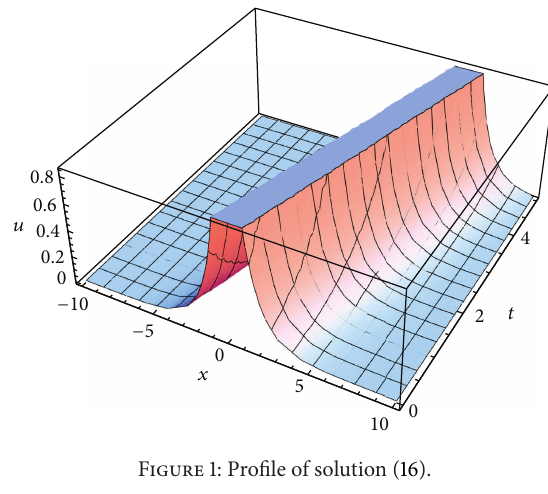
Figure 1: Profile of solution (16).